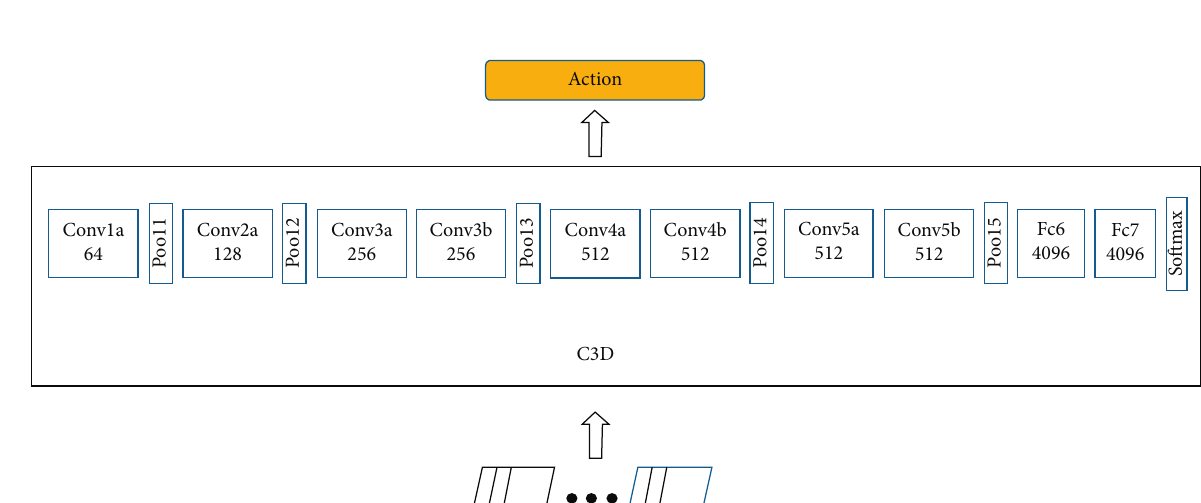
Figure 9: Structure of the 3D ConvNets model.